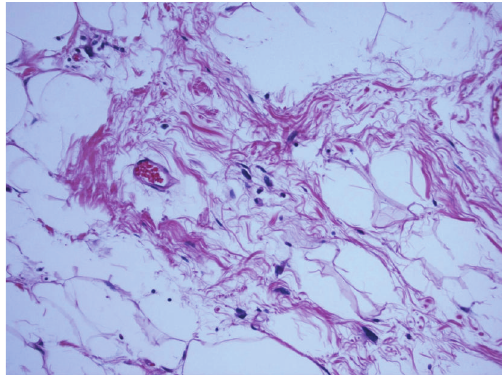
Figure 4: Some areas of the dedi ff erentiated component were com- prised of cells with varying amounts of eosinophilic